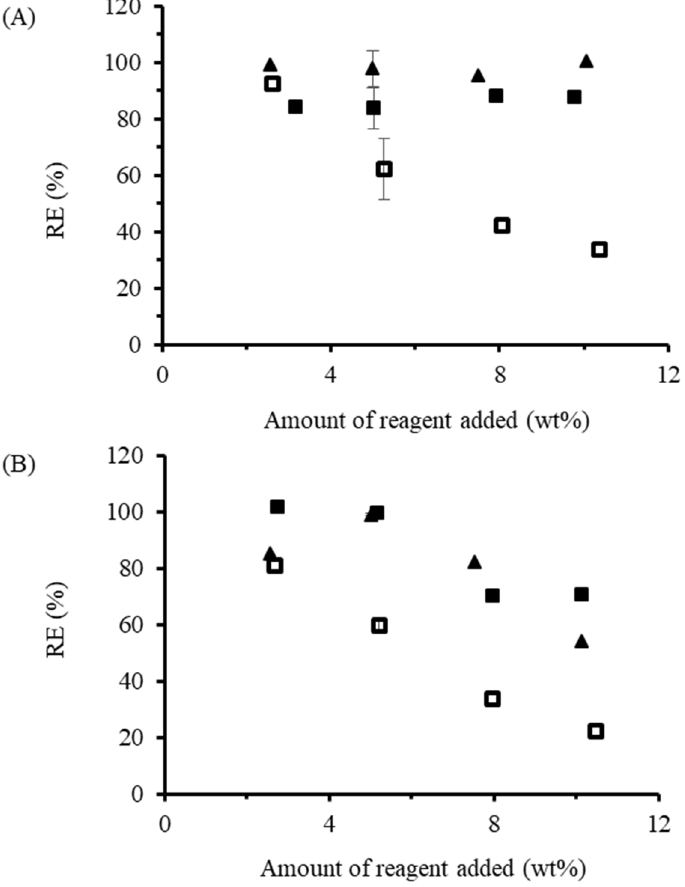
Figure 3. Modification of starch with ( A ) OSA and ( B ) DDSA. Conversion at different weight loadings for ( ▲ ) gelatinized starch dispersions, ( □ ) melt mixer reactions without base, and ( ■ ) melt mixer reactions with base.